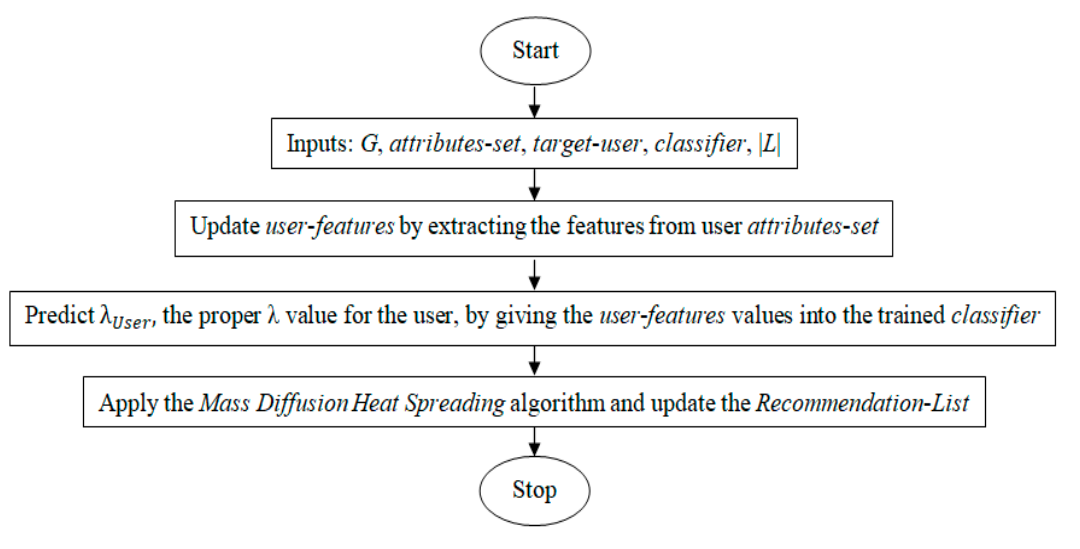
Figure 4. The Flowchart of the Recommendation Step of the Proposed Method 2. Algorithm 6: Specific Features based Recommendation